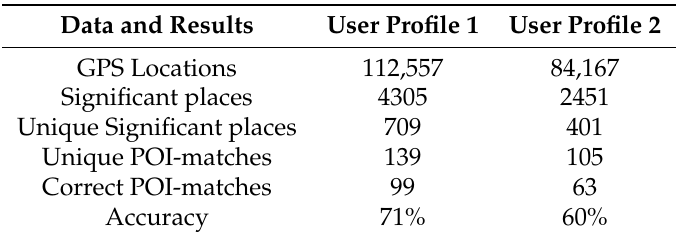
Table 1. POI-matching results for two large user profiles with data for a period of about two years: from 8 January 2014–17 February